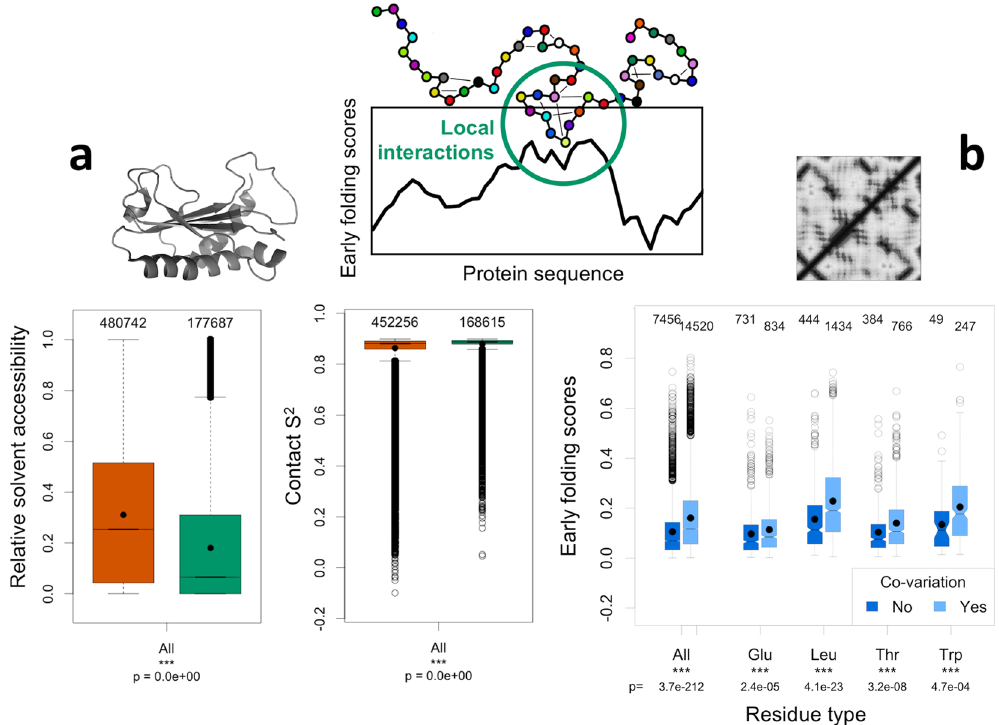
Figure 5. Comparison of early folding scores to structure-related data. The early folding prediction scores (black graph, top) indicate which residues in the sequences will form structure first through local interaction between amino acids (green circle, top). These predictions are compared to ( a ) the relative solvent accessibility and the contact-S 2 calculated from 2939 non-redundant PDB structures, with significant differences between the distribution of their values for the early folding residues (green) and other residues (brown), and ( b ) residues with evolutionary co-variation signals (light blue), which have higher early folding prediction scores than other residues (dark